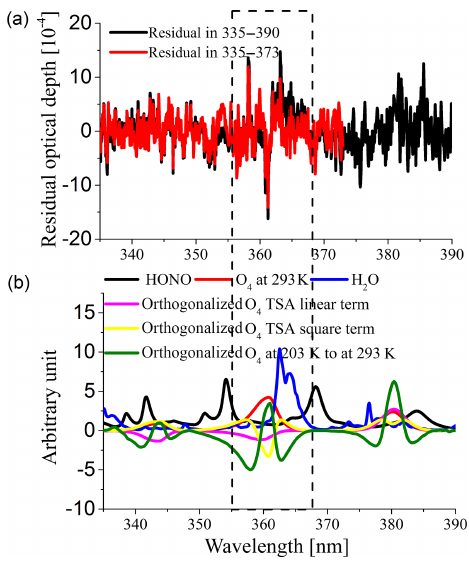
Figure 9. (a) Residual structure from baseline fits with a sequential FRS of the measured spectrum at 1 ◦ elevation angle around noon on 16 June 2013 in the spectral range of 335–390nm (black) and 335–373nm (red). (b) Normalized absorption cross sections used in the HONO baseline